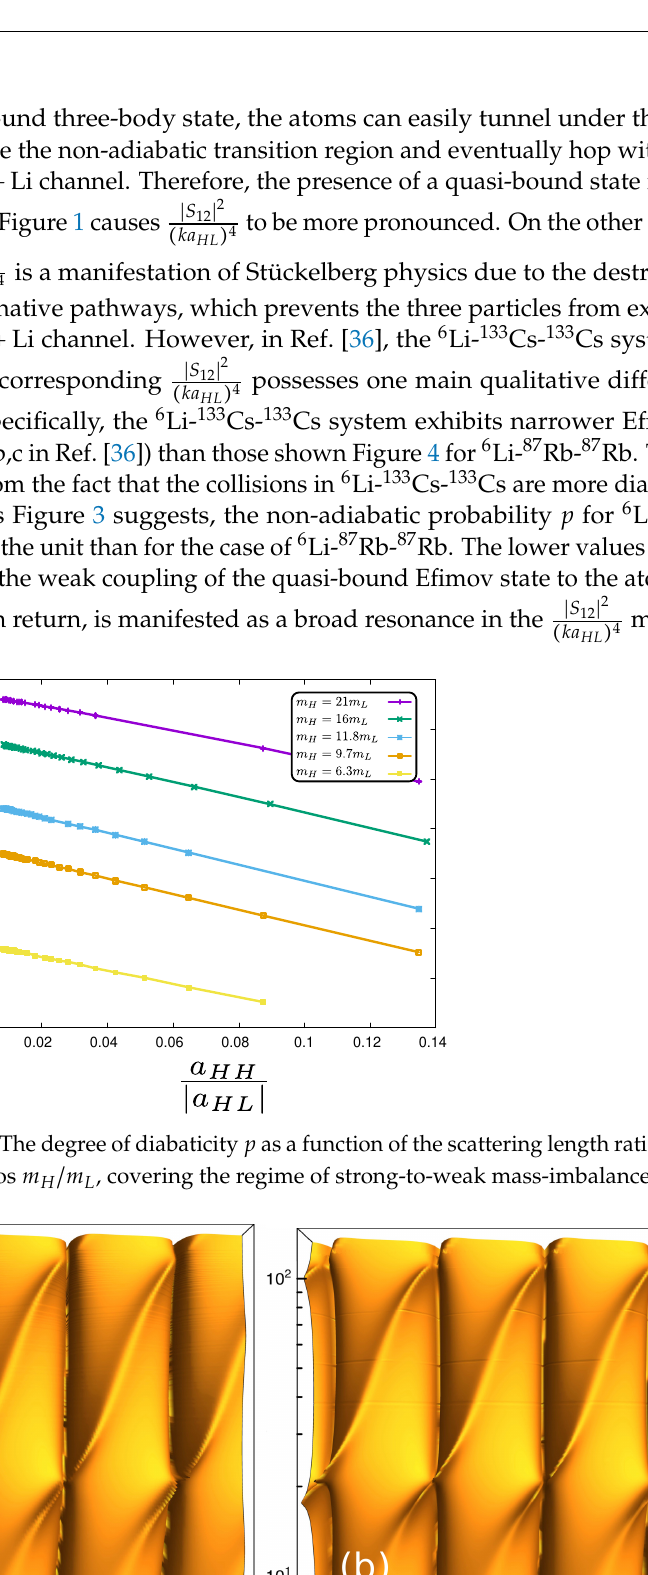
∣ S 12 ∣ 2 Figure 4. The scaled matrix element versus the ratios ( ka HL ) 4 E = ¯ h 2 k 2 . ( a ) Semi-classical approach and ( b ) R-matrix numerical 2 µ